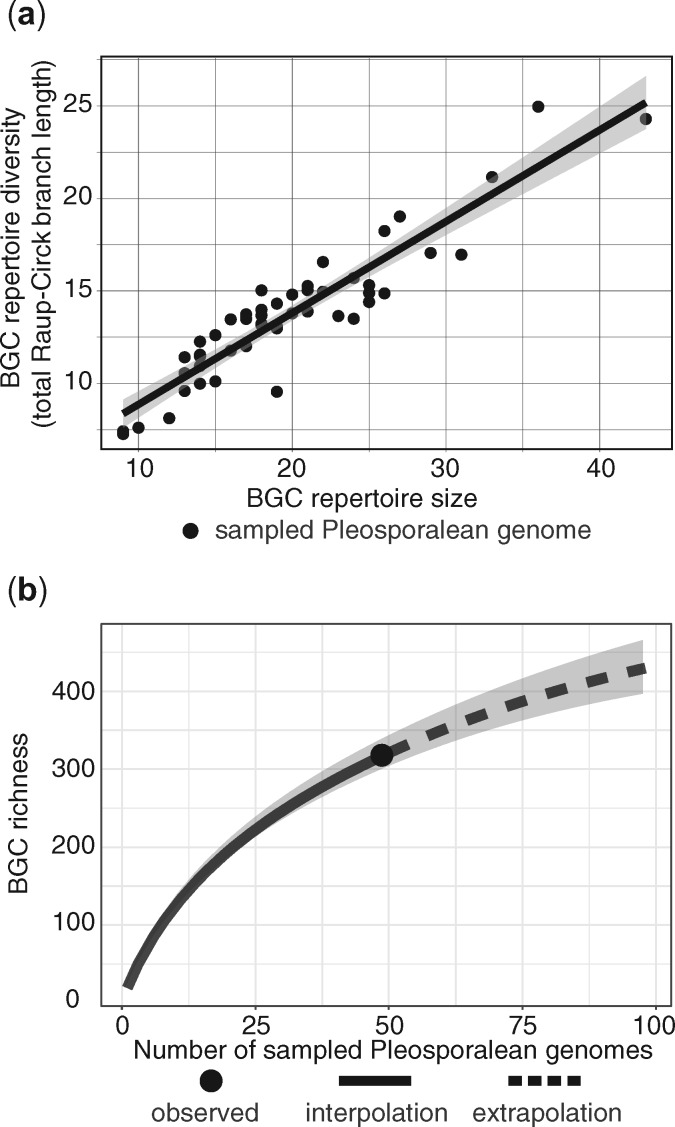
Diversity of SM gene BGC repertoires in Pleosporalean fungi. (a) Relationship between BGC repertoire size and BGC repertoire diversity. BGC repertoire diversity was calculated for each genome by finding the total branch length on the Raup–Crick dissimilarity tree in (a) associated with the set of clusters found in that genome. BGC repertoire diversity is thus a measurement of a given genome’s repertoire diversity, in terms of the gene content of its clusters. A solid line models the linear relationship between repertoire size and diversity (adj. R2 = 0.855). The shaded area around the line represents the 95% confidence interval associated with the model. (b) Sampled and projected SM cluster richness within the Pleosporales. Rarefied (solid lines) and extrapolated (dotted lines) estimates of SM gene cluster richness (i.e., the number of unique BGC families) with respect to the number of sampled genomes are shown for the Pleosporales. Shaded areas represent the 95% confidence intervals for both estimate types, derived from 100 bootstrap replicates. All three graphs were generated using data from the 318 unique BGC families with ≥4 unique gene homolog groups that are associated with 47 Pleosporalean fungi and 2 as yet unclassified fungi found within the Pleosporalean clade on the phylogenomic species tree in figure 2.